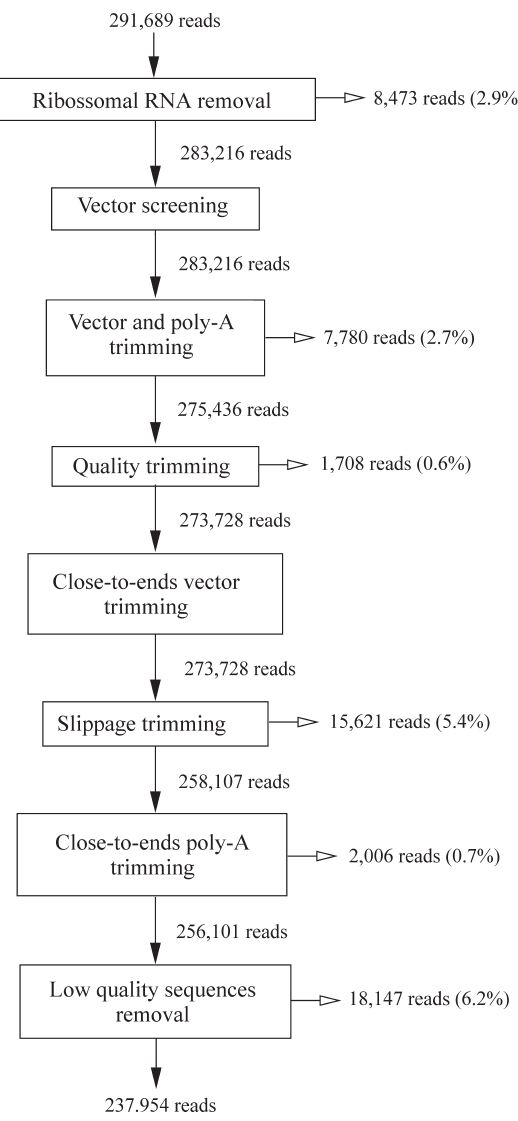
Figure 1 - Overview of trimming procedure. White-headed arrows indi- cate the number of reads discarded in each step, with the percentage of to - tal shown in